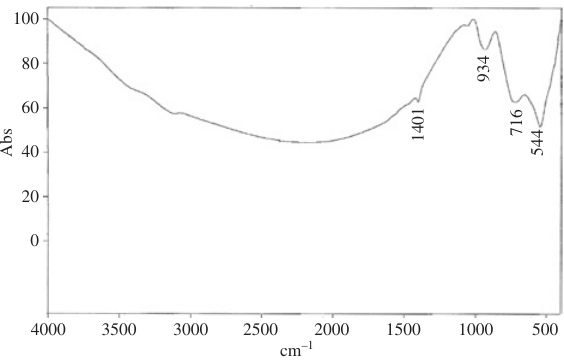
O /TiO nanocomposites. 12 19 2